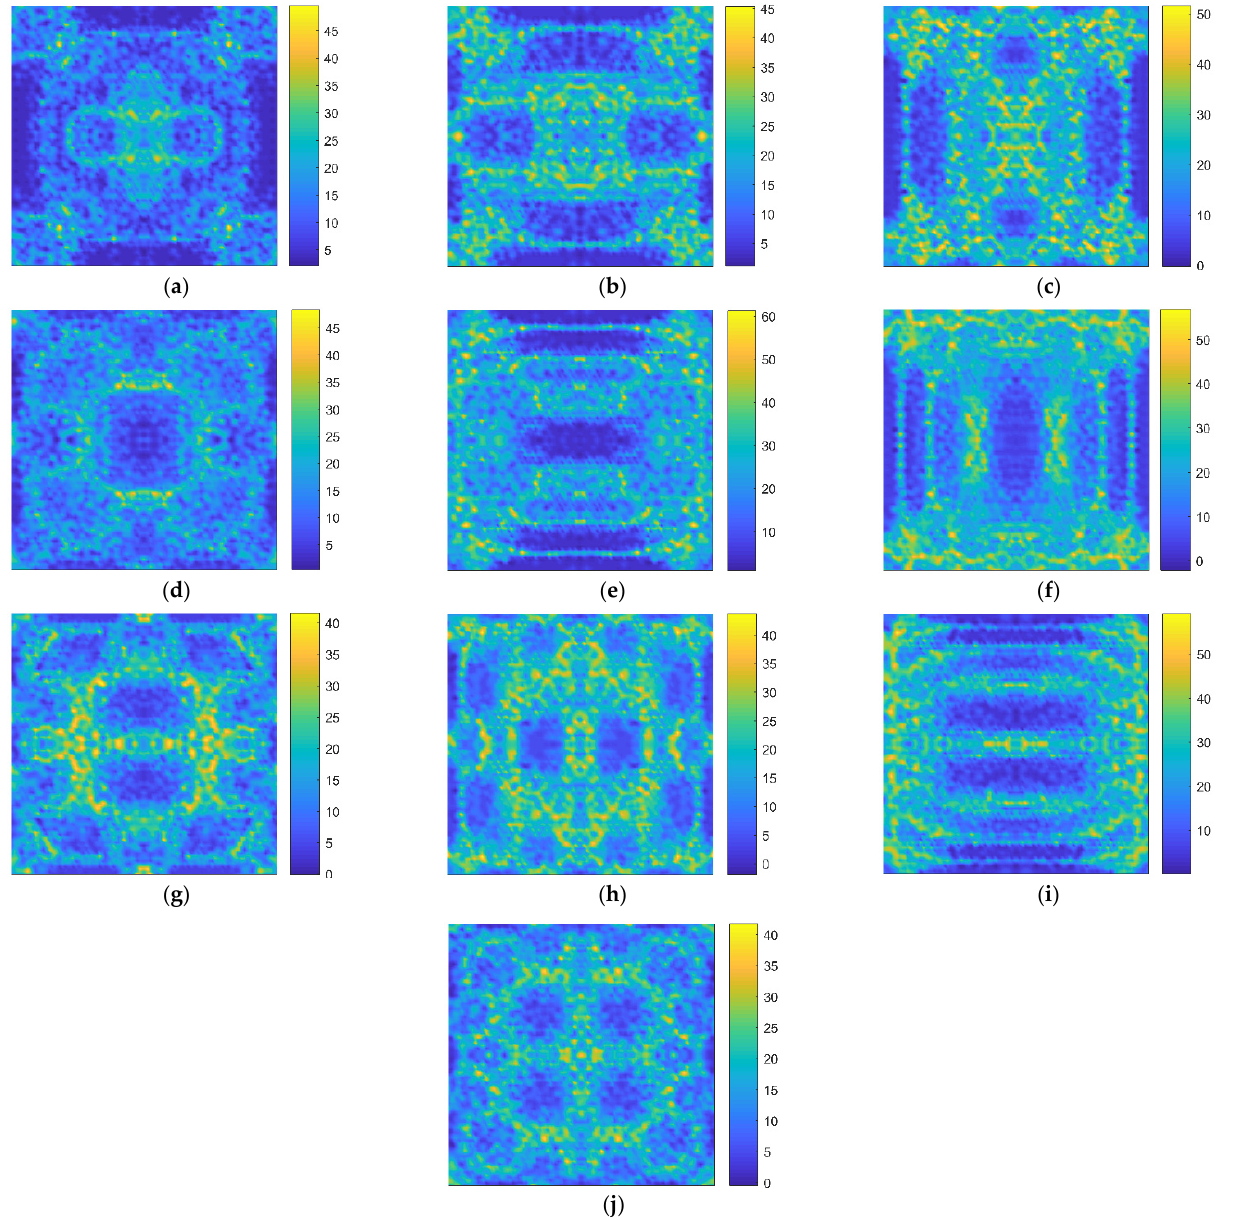
Figure 6. The number distributions of indistinguishable atoms with the identification limitation at 10 − 6 Thz (( a – j ) represent the distributions from the 1st to the 10th resonant vibration modes, respectively).